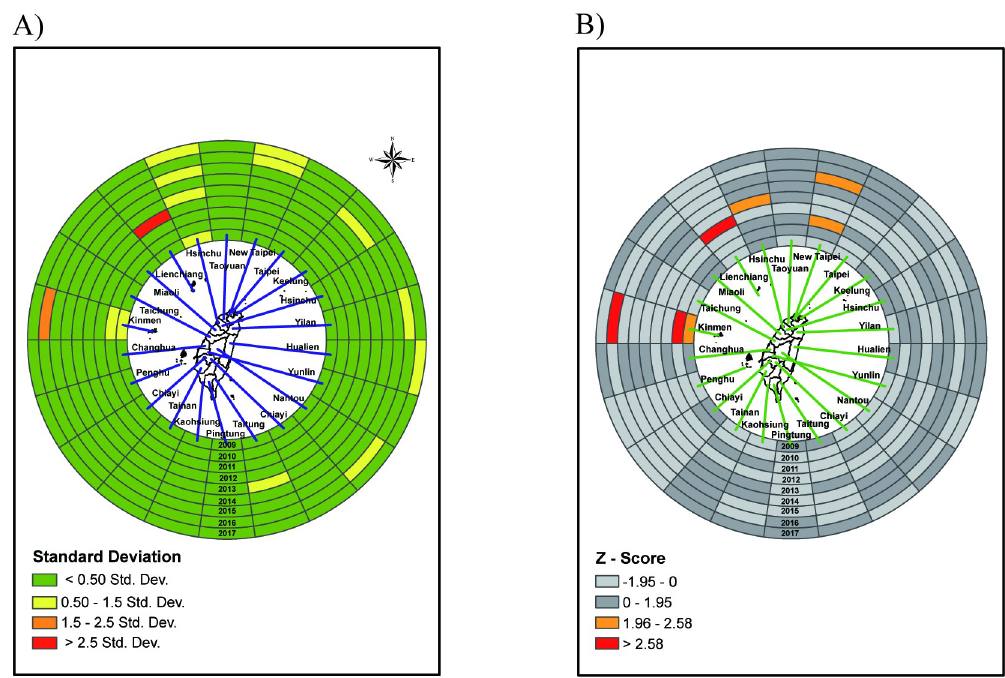
Fig 5. Ring map of hospitalization rate of scarlet fever in age group 5–9 years. (A) A Z score ring map from innermost in 2009 to outermost in 2017. (B) A ring map of Z-scores by applying spatio-temporal G